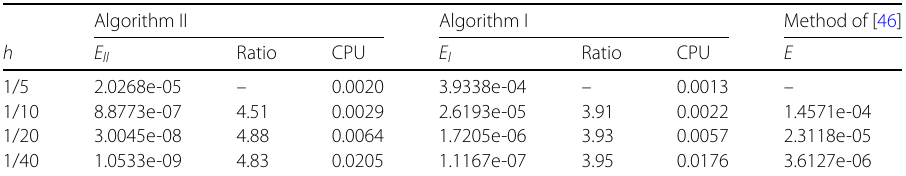
Table 3 Absolute errors of the present presented algorithm I ( E I ), algorithm II ( E II ), and the numerical methods of [46], with α = 0.3 for